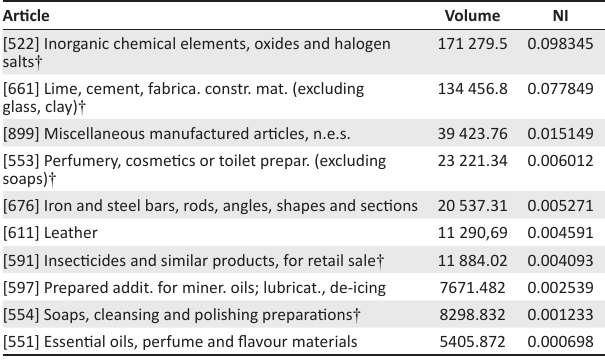
TABLE 1: Top 10 Senegalese revealed comparative advantage in manufacturing industries